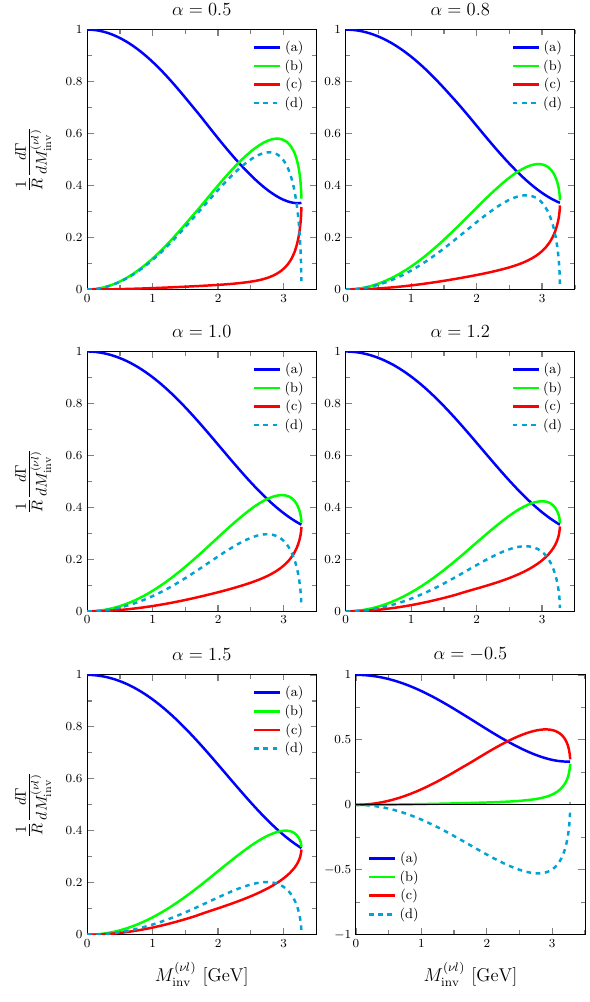
Fig. 10 The same as Fig. 5 but from Eqs. (46), (47), (48), and (49)